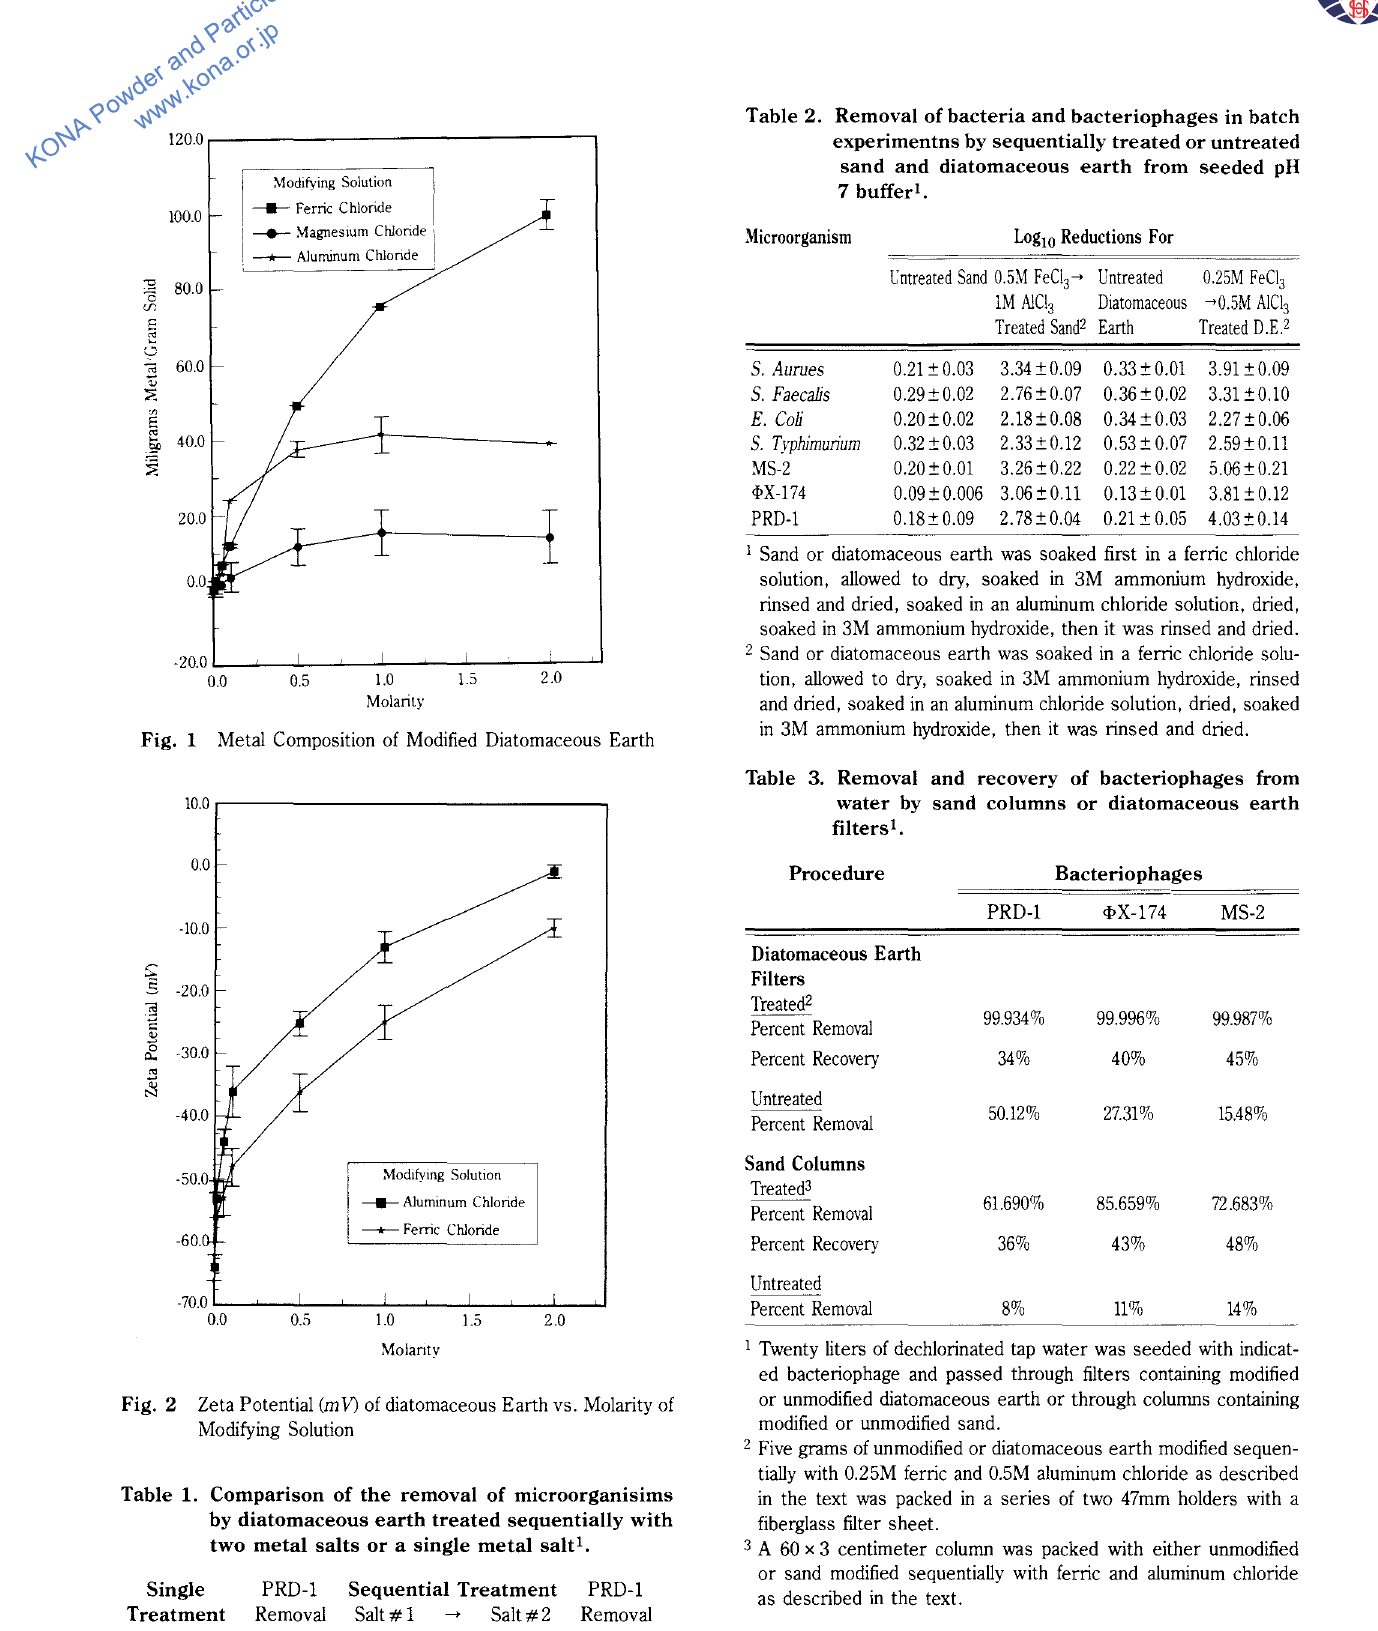
Fig. 2 Zeta Potential (mV) of diatomaceous Earth vs. Molarity of Modifying Solution Table 1. Comparison of the removal of microorganisims by diatomaceous earth treated sequentially with two metal salts or a single metal saltl. Single PRD-1